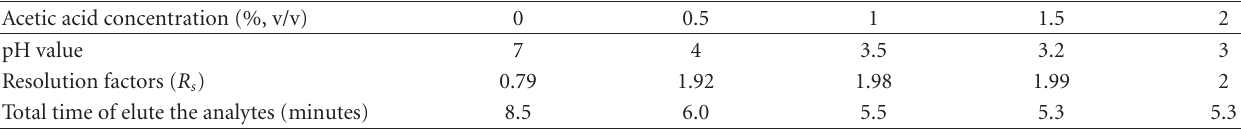
Table 1: E ff ect of acetic acid percentage in phase B of mobile phase on pH, resolution factors, and total analysis time.